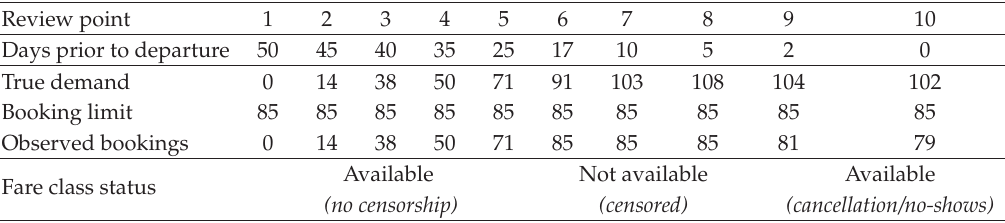
Table 2: Review point to days prior to mapping and booking matrix with demand censoring of a fare class. Review